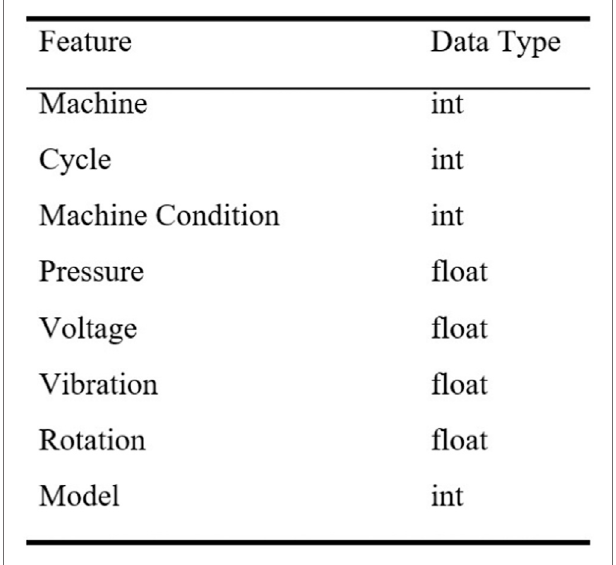
FIGURE 8 | Sample data features from FIRST for training the predictive model.